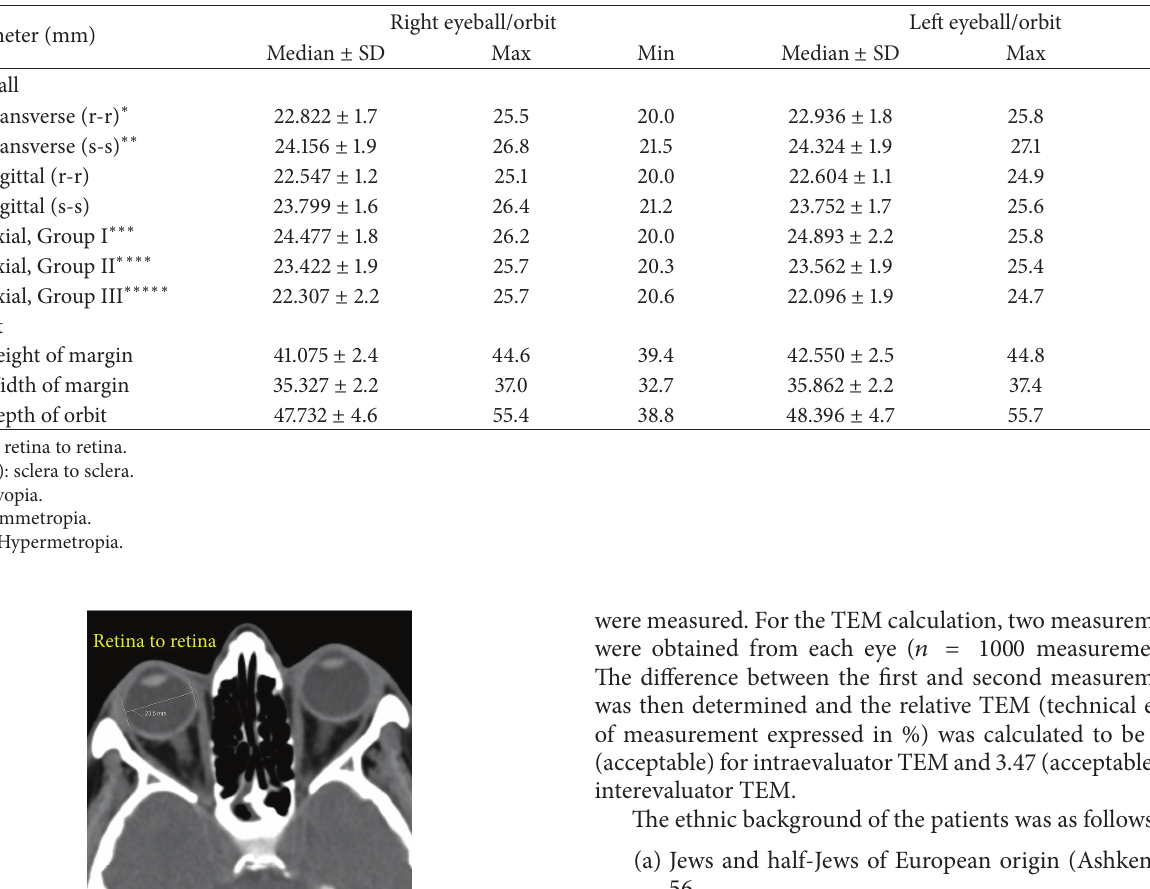
Table 1: Eyeball and orbit diameters measured by computed tomography.